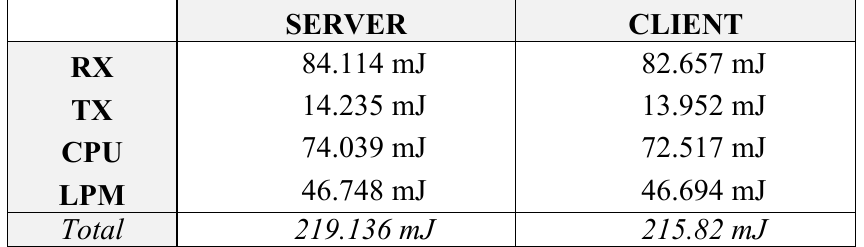
Table 5. SM-packet energy consumption calculation (ContikiMAC RDC